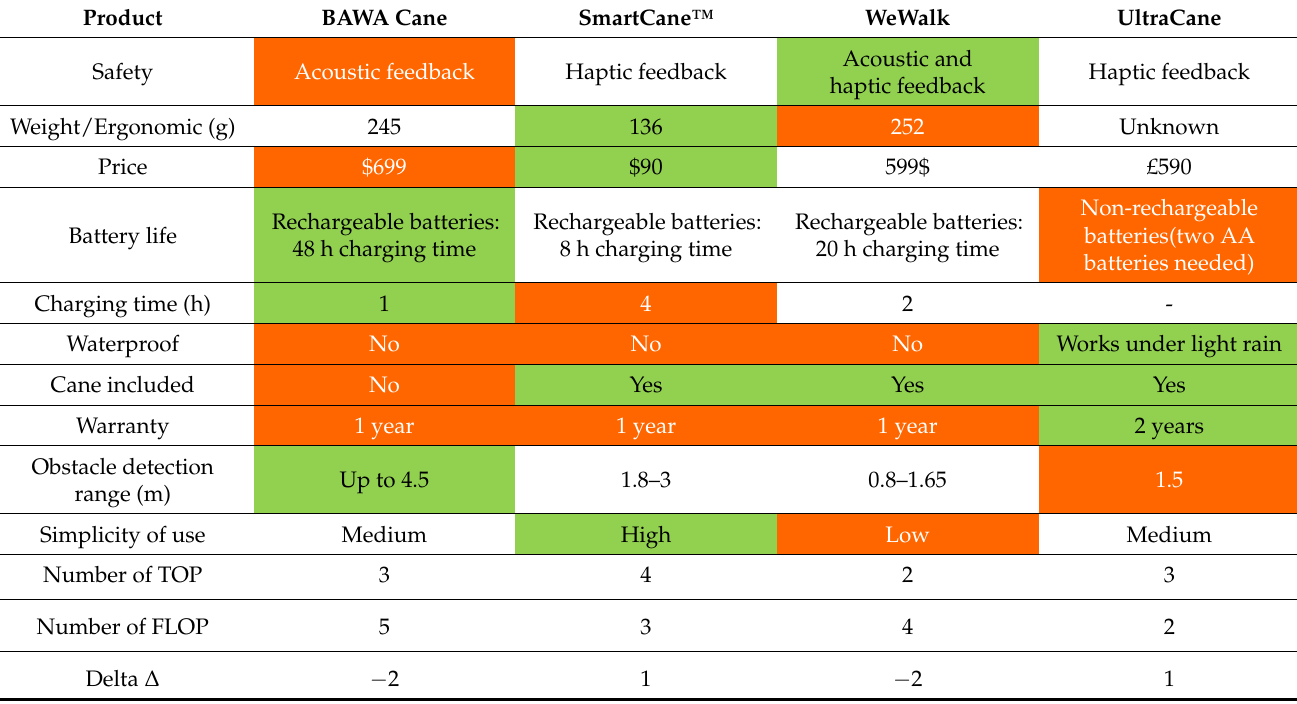
Table 7. Top-flop analysis.